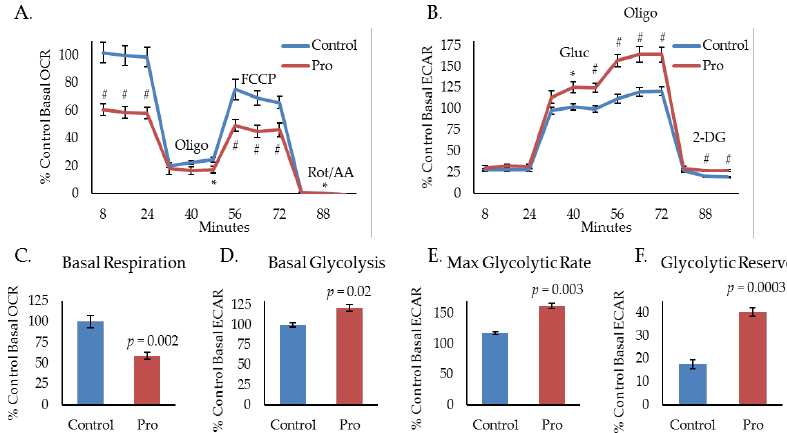
Figure 1. Propranolol alters tumor cell metabolism. Mitochondrial ( A ) and glycolytic stress test ( B ) results of MLM3 cells treated with propranolol (40 μ M) showing propranolol-mediated changes in basal mitochondrial respiration ( C ), basal glycolysis ( D ), maximum glycolytic rate ( E ), and glycolytic reserve ( F ). Data are represented as % control basal oxygen consumption rate (OCR) (average of first three measurements) or extracellular acidification rate (ECAR) (average of three measurements immediately following glucose injection). Each data point represents mean +/ − SEM of n = 9 (mitochondrial stress test) or 5 (glycolytic stress test) independent biological replicates; p -values reflect t -test results (* p ≤ 0.03; # p ≤